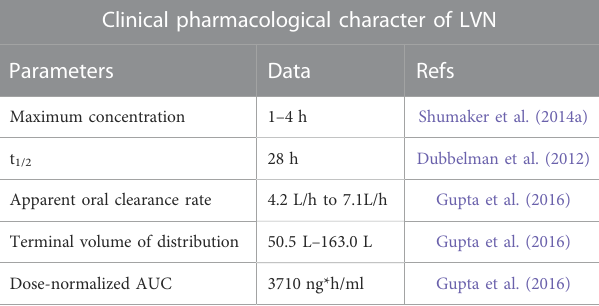
TABLE 1 Clinical pharmacological character of